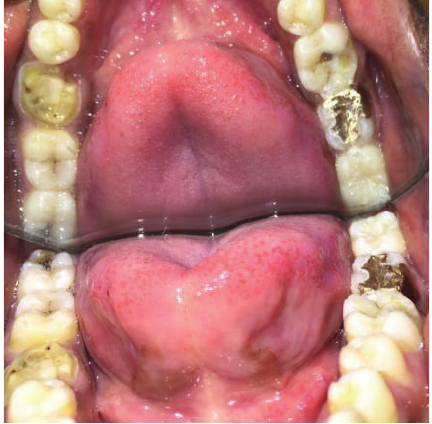
Figure 20: Photograph showing inlay luted with respect to 37 (occlusal view).